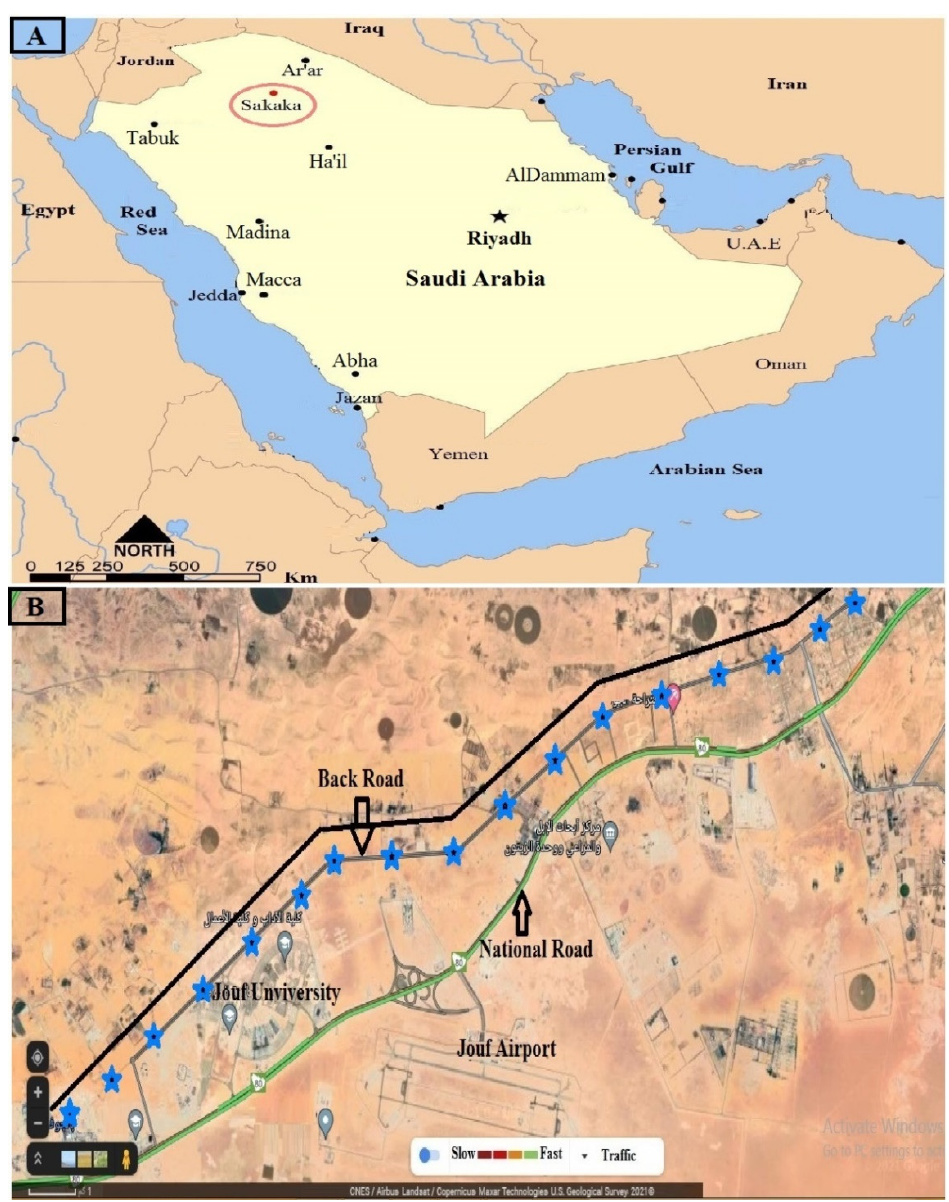
Figure 1. ( A ). Illustrated map of Saudi provinces showing the geographical location of Sakaka city in the Aljouf region. ( B ). Topographic Google Map showing the collection points of samplesalong the back road of Jouf University in Sakaka. Blue asterisks refer to the points of collection.